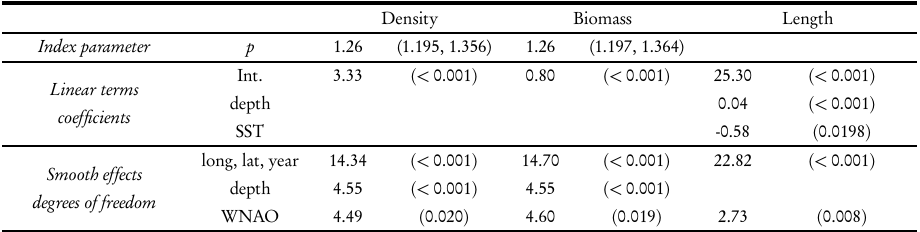
Model estimates for Parapenaeus longirostris a